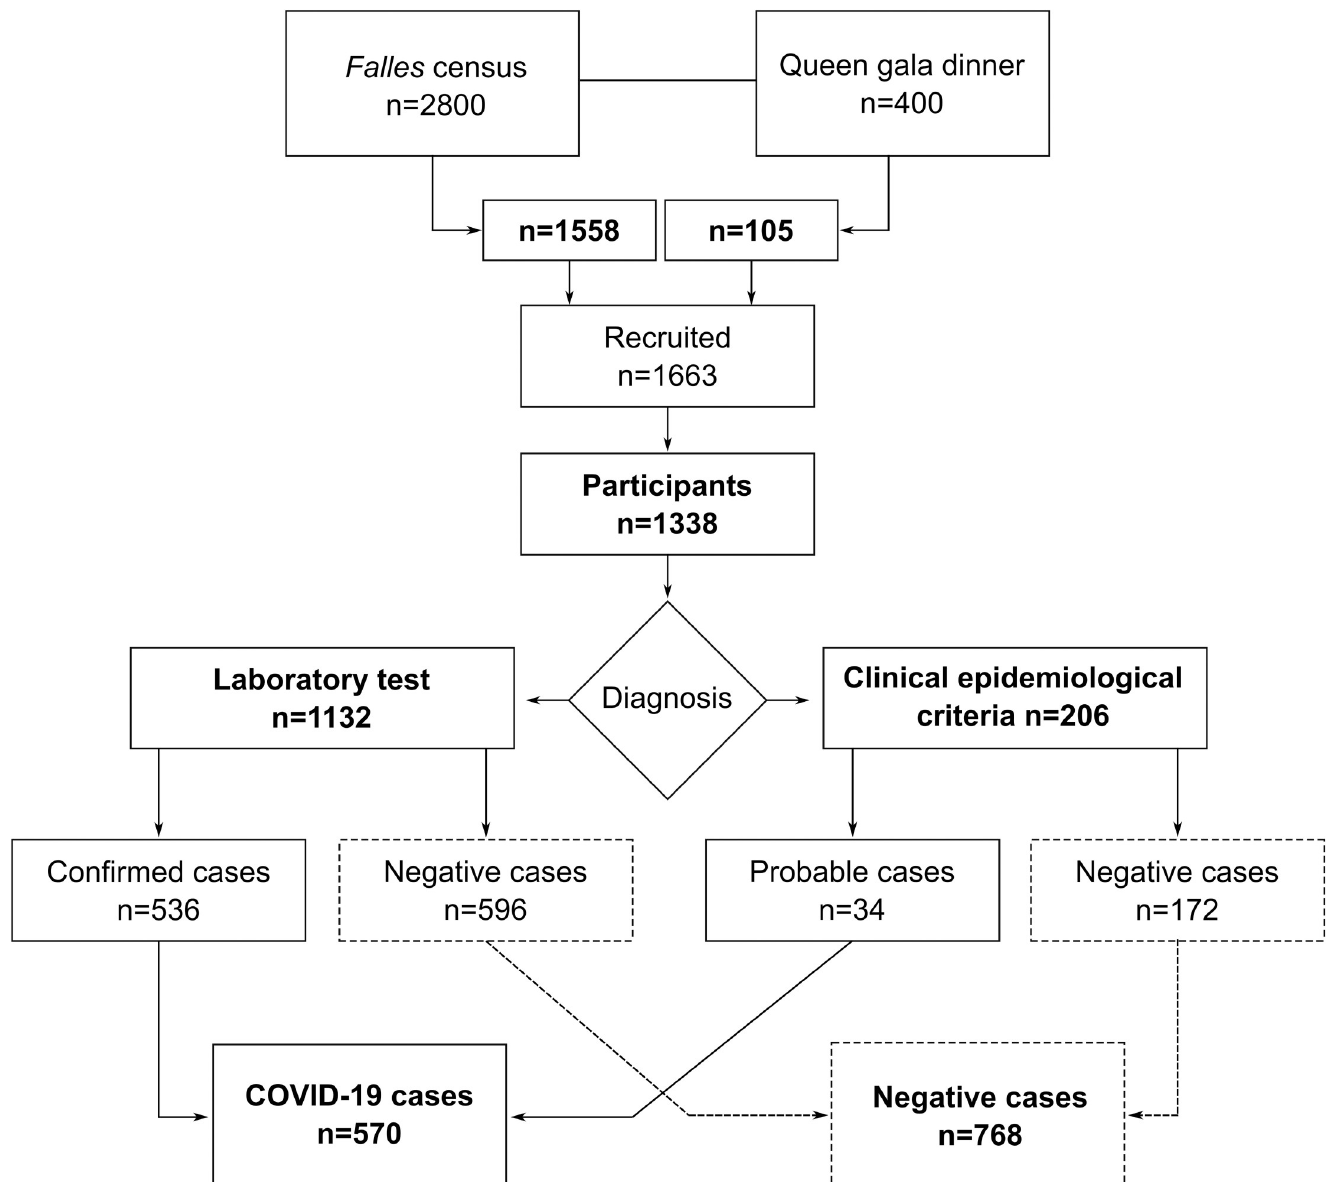
Fig 1. Flow diagram of the study population in the MGEs in Borriana between January and June 2020. COVID-19 cases included those diagnosed by laboratory tests (confirmed cases) or by clinical and epidemiological criteria (probable cases). Cases confirmed by laboratory tests included participants with positive results from the serologic survey as well as from private and public medical